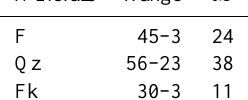
Table 6. Mineral composition of soil samples (%).